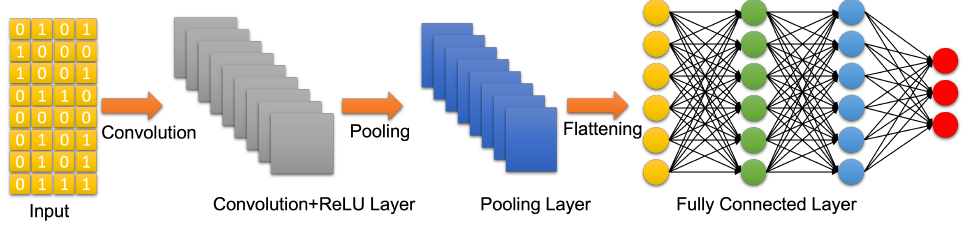
Figure 4. Convolutional neural network